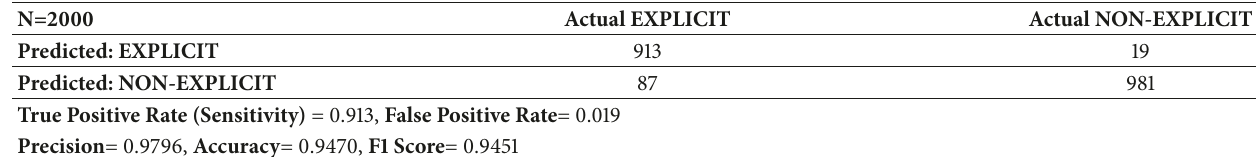
Table 3: Confusion matrix for images dataset using proposed ECD system.